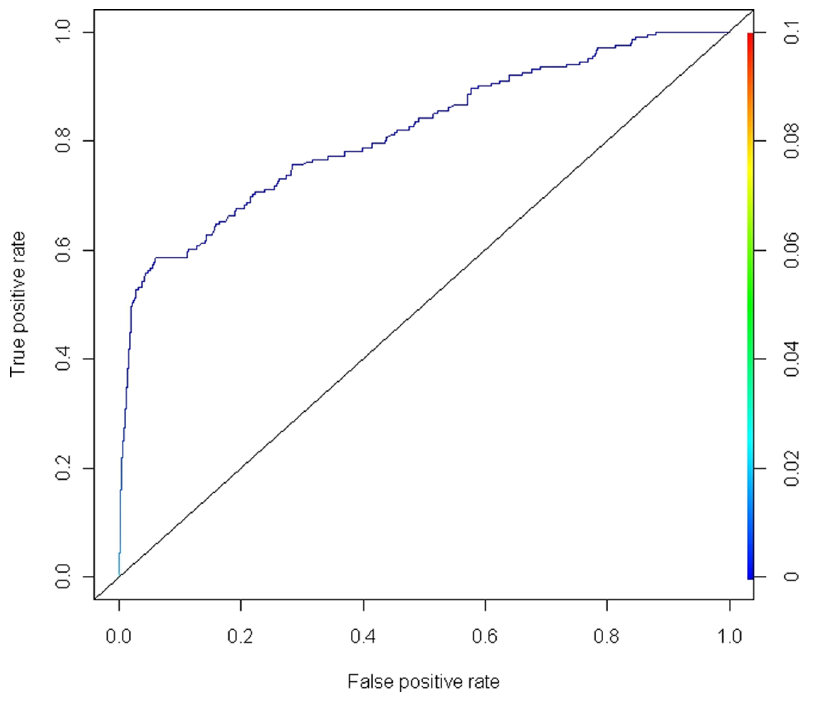
Figure 4. Performance of ExprTarget, an integrative prediction algorithm. ExprTarget was assessed by plotting the ROC curve, which shows the true positive rate (sensitivity) and the false positive rate (1-specificity) at various thresholds. The database of manually-curated experimentally verified targets, TarBase, was used as gold standard. The line of no-discrimination was drawn from the left bottom to the top right corners.